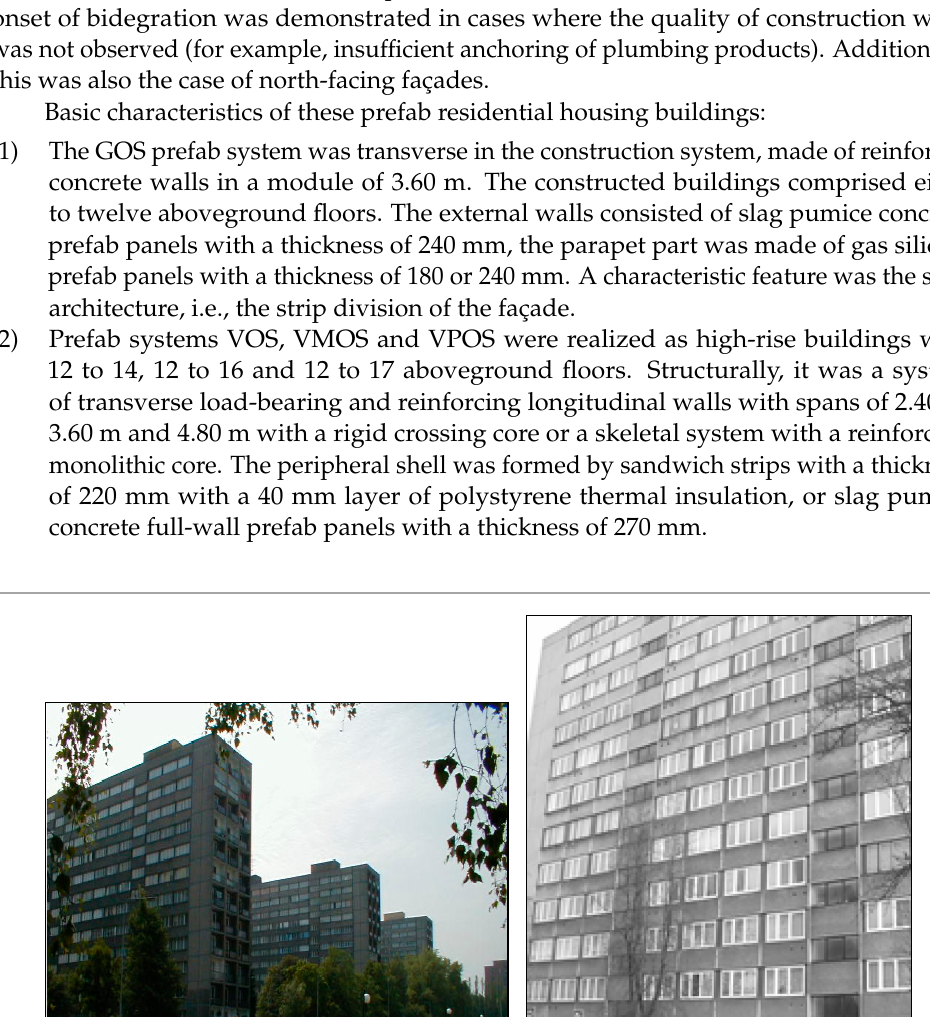
Figure A2. Prefabricated residential housing buildings before renovation: ( a ) VOS system; ( b ) orig- inal perimeter cladding not meeting thermal requirements [61]; VMOS system; ( c ) VPOS system.